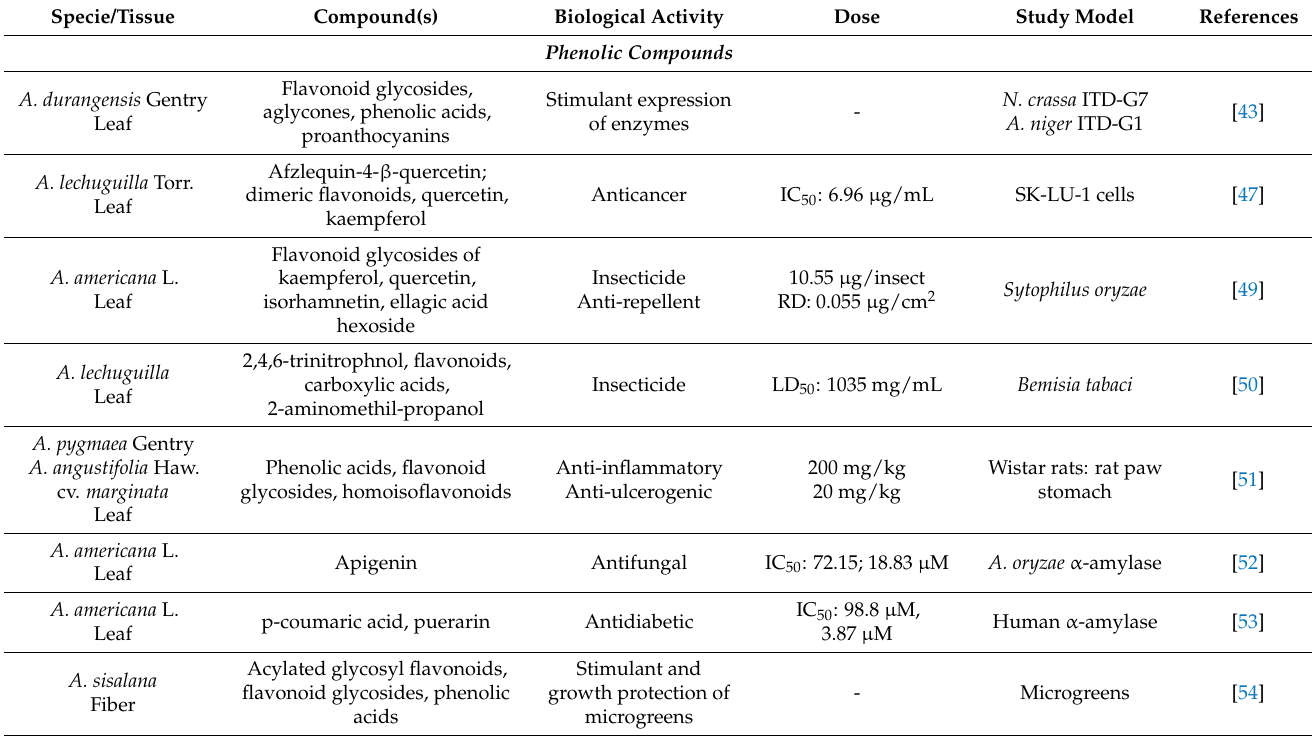
Table 2. Biological activity of identified/isolated phytochemicals from the Agave